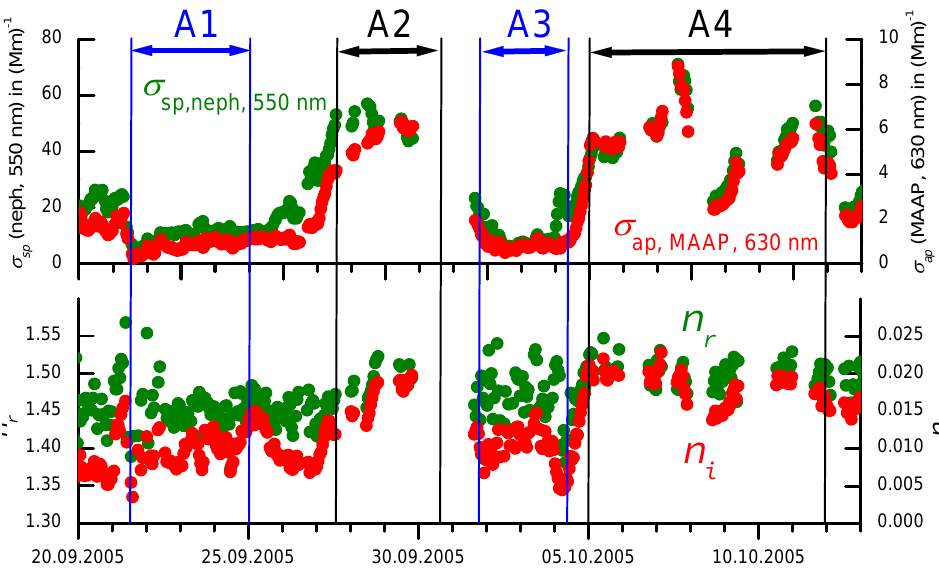
Fig. 10. Optical measurements and simulations at dry conditions. Upper graph: total scattering coefficients at550nm ( σ sp , neph , 550nm ) and absorption coefficients at 630nm ( σ ap , MAAP , 630nm ) measured by the nephelometer and the MAAP. Bottom graph: real and imaginary parts of the retrieved refractive indices ( n r and n i ). Periods covering marine (A1, A3) and continentally polluted air masses (A2, A4) are marked.